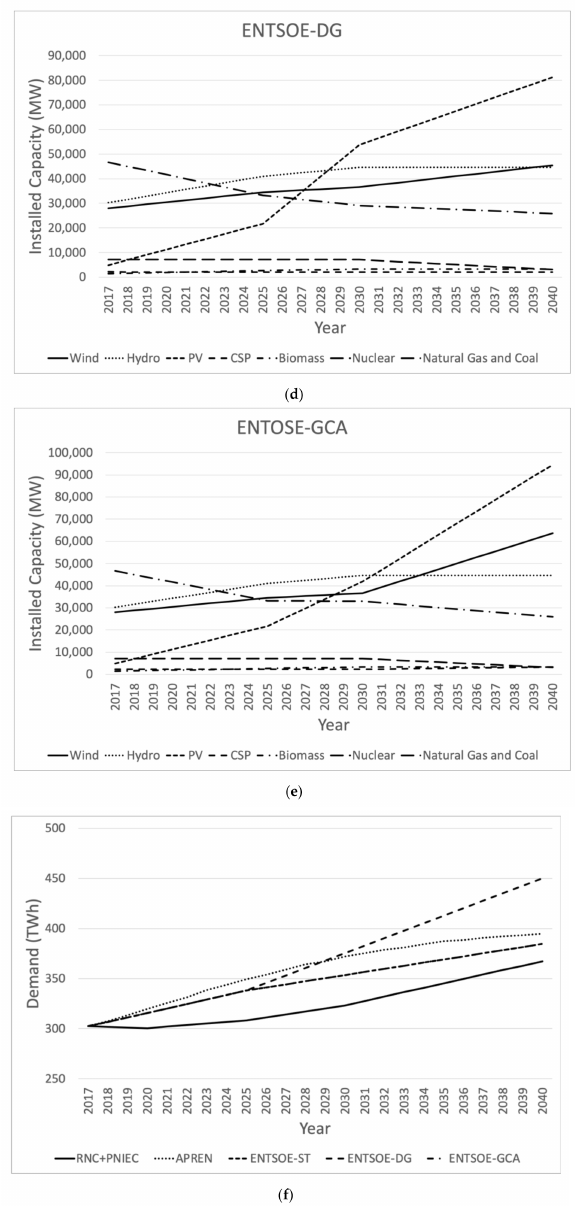
Figure 3. Evolution of the generation installed capacity and demand, as foreseen by the projections, from 2017 to 2040: ( a ) RNC + PNIEC; ( b ) APREN; ( c ) ENTSOE-ST; ( d ) ENTSOE-DG; ( e ) ENTSOE-GCA; ( f )